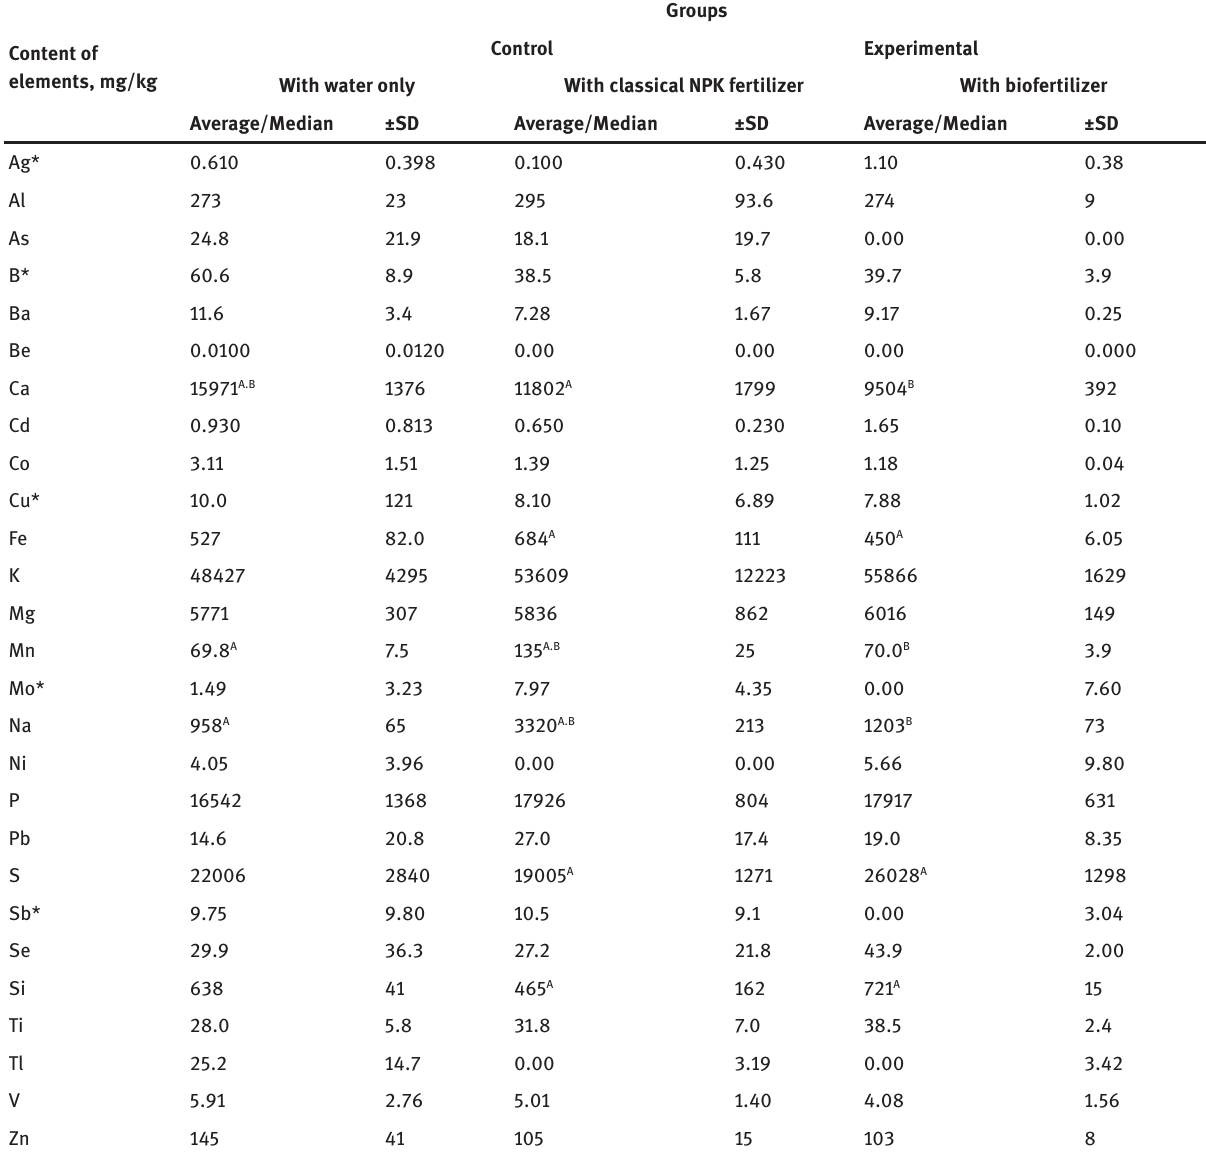
Table 4: The content of elements in plant Groups Control Experimental Content of elements, mg/kg With water only With classical NPK fertilizer With